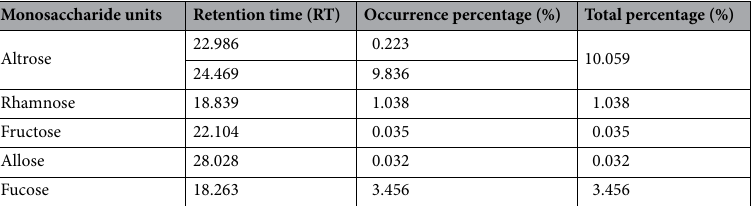
Table 4. Monosaccharide composition of exopolysaccharide isolated from the diatom Nitzschia palea.